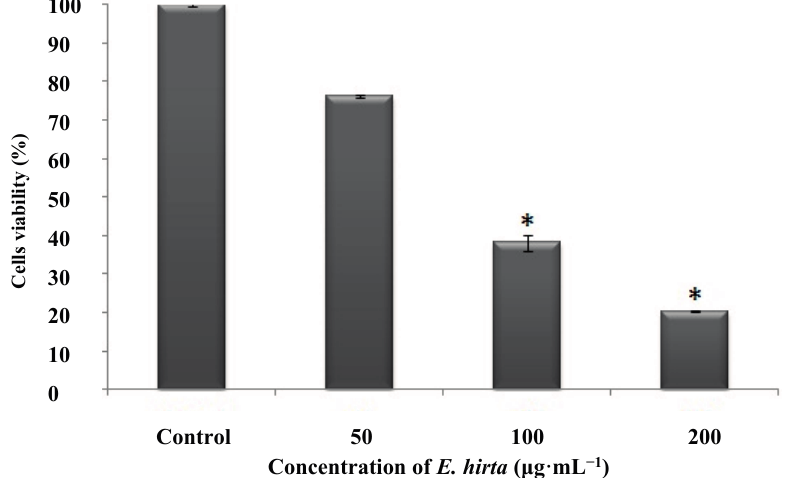
Figure 7. Anticancer activity of ethanol extract of E. hirta on myeloid leukemia cell line (HL-60) in vitro . Cells (2 × 10 4 ) were incubated with E. hirta (50, 100, 200 μ g/mL) at 37 °C for 24 h. Cells viabilities were evaluated using MTT assays. Data represent the means ± SDs of three independent experiments. * Significant reduction in cell viability at p <